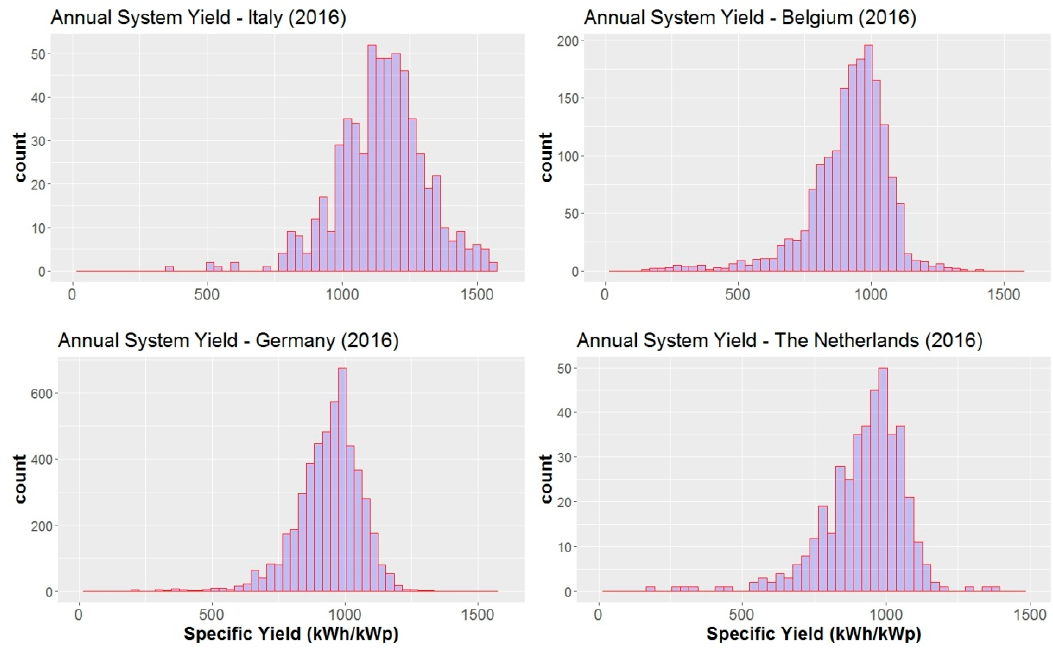
Figure 4. Distribution of specific yield for the year 2016 for Italy, Germany, Belgium, and the Netherlands.